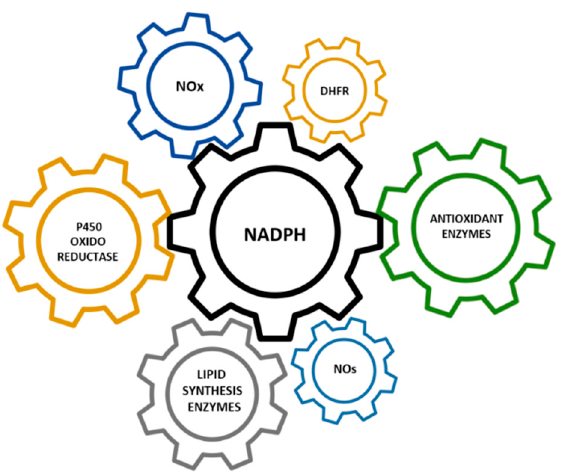
Figure 2. NADPH-dependent enzymes. NOs—nitric oxide synthases; NOx—NADPH-oxidase enzymes; DHFR—dihydrofolate reductase.